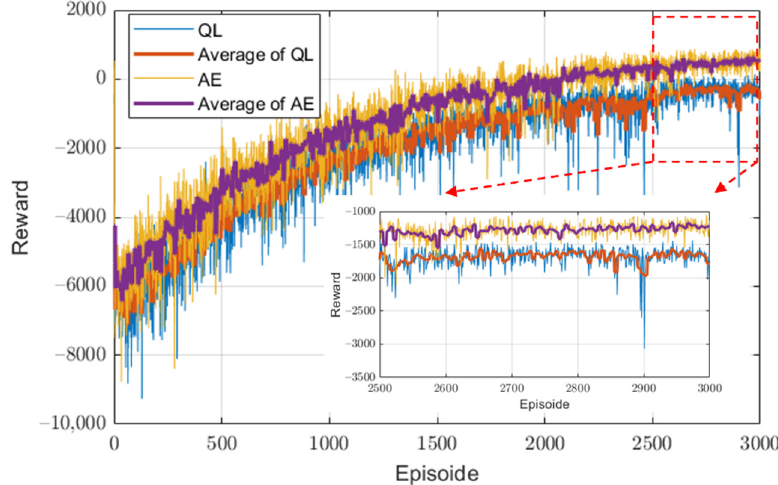
Figure 7. Rewards and average rewards of QL and AE.